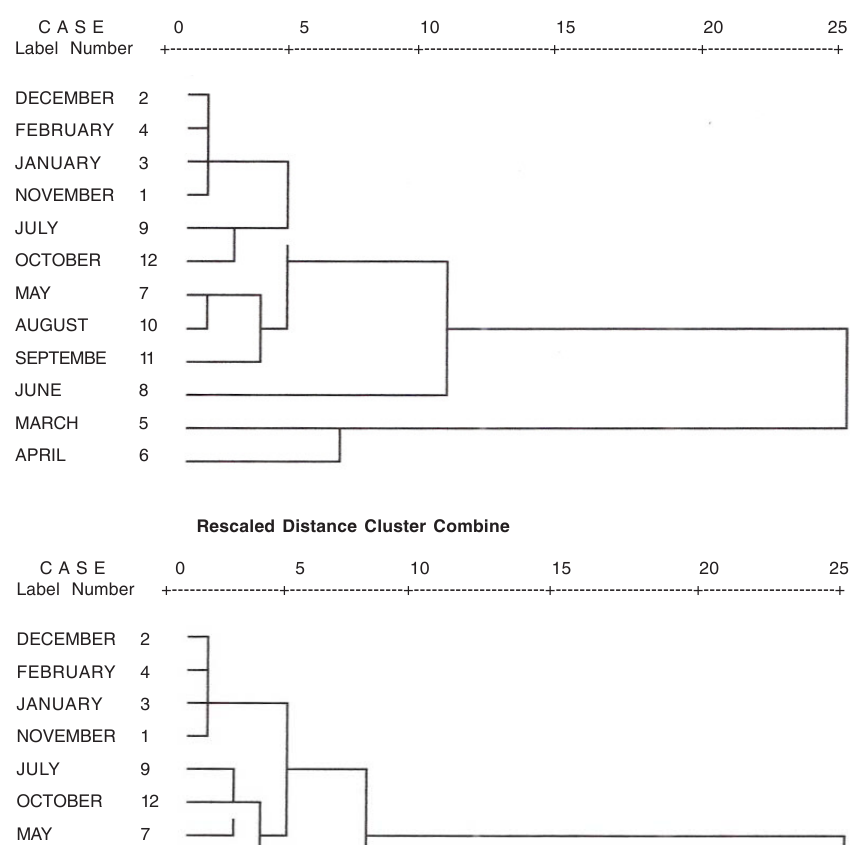
Figure 4. Hierarchical cluster analysis of Microcrustacea (Station II)